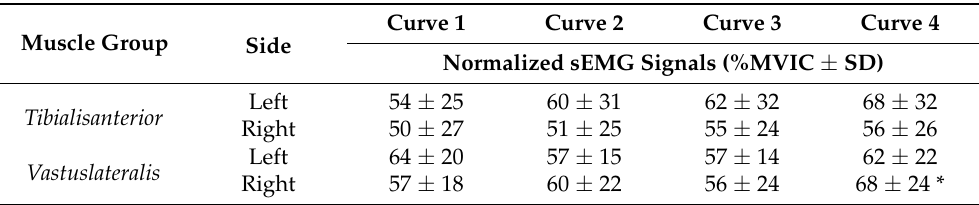
Table 2. Comparison of normalized sEMG signals for selected posterior thigh muscles while running successive curves on the 400 m track. Curve Muscle Group Side